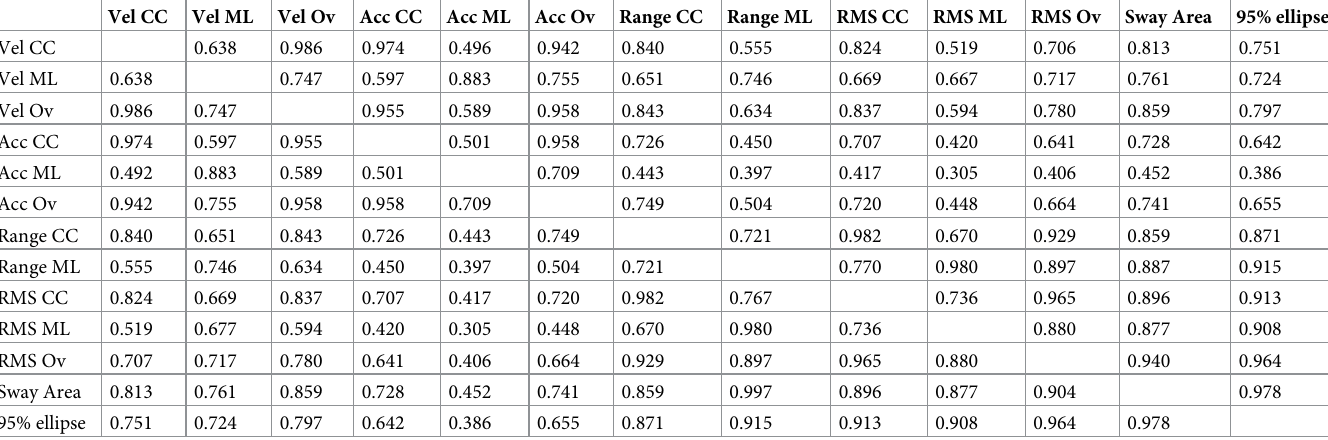
Correlations were estimated by Row-wise method, and correlation values are shown at the bottom right corner of each scatterplot. For this analysis, we included all the dogs used in the study (Group A + Group B).